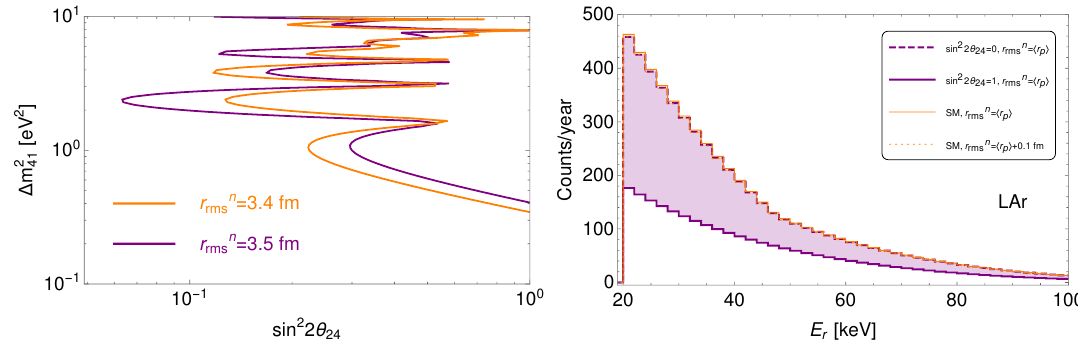
Figure 6 . Left : 90% C.L. exclusion regions in the case of sterile neutrinos in the 3+1 scheme ob- tainable from a one ton LAr COHERENT detector with four years of data taking. The neutron rms radius is h r p i for the orange contour and 3.5 fm for the purple contour. Right : the orange histograms show the SM expectation for the event spectrum including neutron form factor uncertainties, while the purple histograms are the spectra expected by (cid:12)xing r n sin 2 (cid:18) 14 = 0 : 01, (cid:18) 34 = 0, with sin 2 2 (cid:18) 24 = 0 and